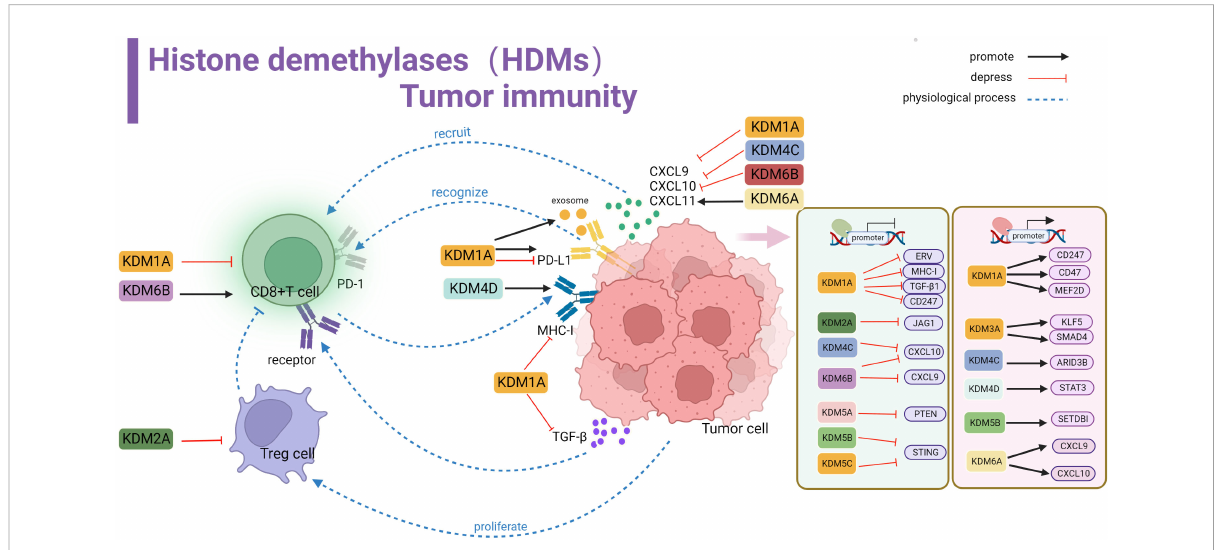
FIGURE 3 Histone demethylase(HDMs) involved in tumor immune summary. In tumor cells, KDM1A, KDM2A, KDM4C, KDM5A, KDM5B, KDM5C and KDM6B negatively regulate key genes and signaling pathways involved in stimulating T-cell anti-tumor immunity, including ERV, MHC-I, TGF- b , CD247, JAG1, CXCL10,9,STING and PTEN, affecting cellular KDM1A, KDM3A, KDM4C, KDM4D, KDM5B, KDM5A positively regulate related proteins involved in activating tumor surface antigens, including CD247,CD47 and other surface antigens, or by promoting MEF2D, KLFS, SMAD4, STAT3, ARID3B, SETDBI to promote or activate downstream KDM5A promotes CXCL9 and CXCL10 recruitment of T cells into the microenvironment. kdm1A inhibits TGF- b binding to T cell-associated receptors and suppresses MHC-I antigen expression. KDM1A promotes PD-L1 expression in exosomes. kdm1A and KDM6B affect T cell function. kdm2A alters the activity of regulatory T